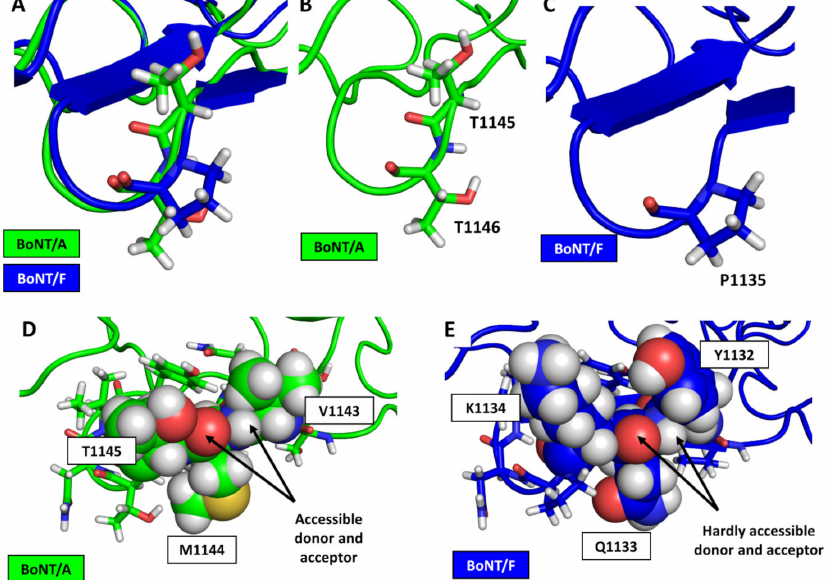
Figure 4. Structural analysis of BoNT/A and BoNT/F at the molecular level. Carbon alpha alignments of BoNT/A1 (green) and BoNT/F1 (blue), with T1145-T1146 of BoNT/A1 and P1135 of BoNT/F represented as lines ( A ). Zoomed-in images of residues T1145 and T1146 of BoNT/A1 ( B ) and residue P1135 of BoNT/F1 ( C ). Spherical representation of amino acids V1143 to T1145 of BoNT/A1 ( D ) and Y1132 to K1134 of BoNT/F1 ( E